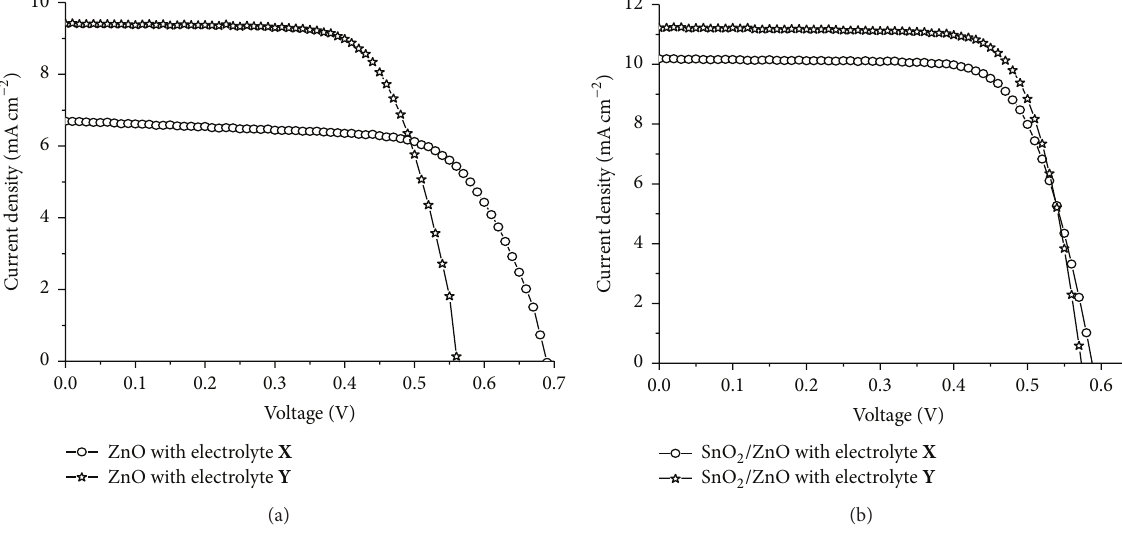
Figure 4: I - V characteristics curves of the QSDSCs fabricated with composite systems: (a) pure ZnO and (b) SnO 2 /ZnO with electrolytes X and Y